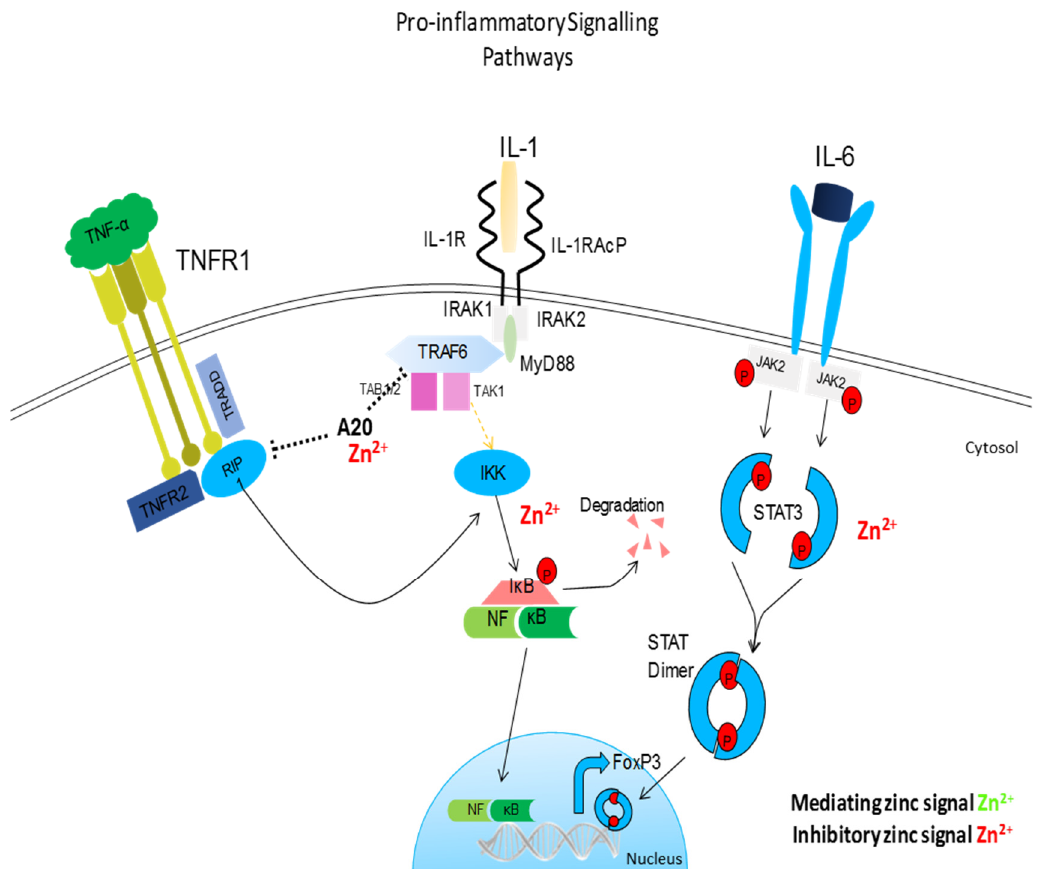
Figure 2. Pro ‐ inflammatory signaling pathway influences by zinc. Similar to TLR signaling, IL ‐ 1, and TNF ‐ R signaling pathways converge on a common I κ B kinase complex that phosphorylates the NF ‐κ B inhibitory protein, resulting in the release of NF ‐κ B and its translocation to the nucleus. Zinc prevents the dissociation of NF ‐κ B from its corresponding inhibitory protein, thus preventing the nuclear translocation of NF ‐κ B and inhibiting subsequent inflammation. Zinc also inhibits IL ‐ 6 ‐ mediated activation of STAT3. Zinc acts as anti ‐ inflammatory element influencing major pro ‐ inflammatory signaling pathways.